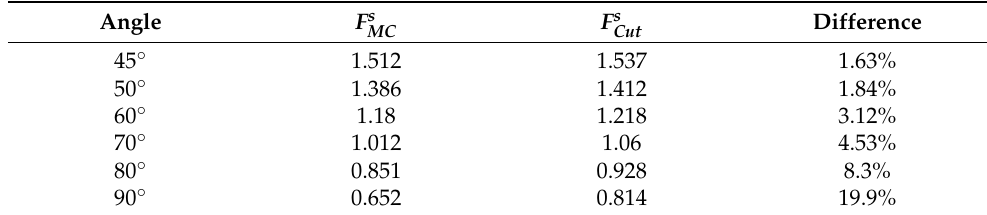
Table 1. Outcomes of different slope angles.